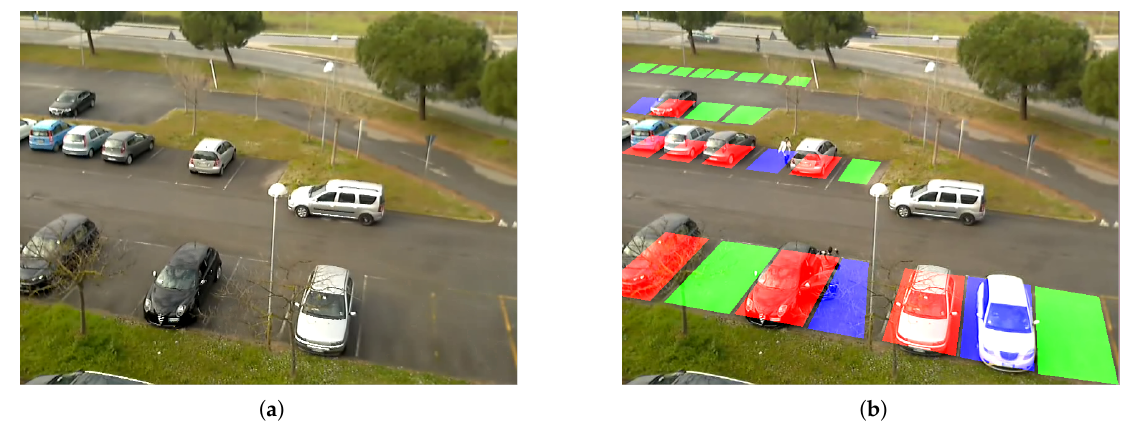
Figure 6. Example of parking lot analysis: background model at time t ( a ) and real-time output at time t ( b